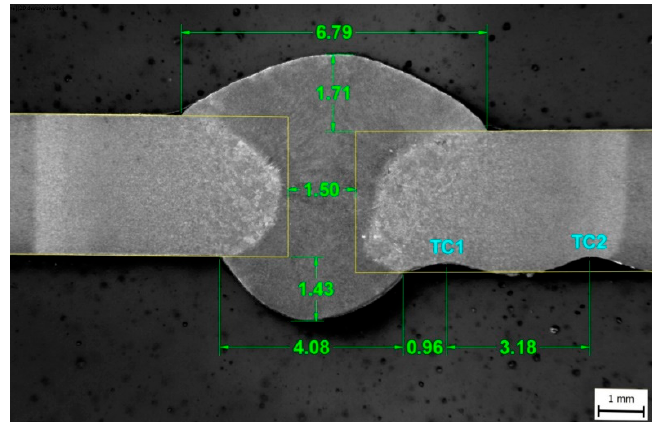
Figure 3. Geometrical evaluation of the experimental butt weld joint with marked points of thermal cycle measurement. (unit: mm)